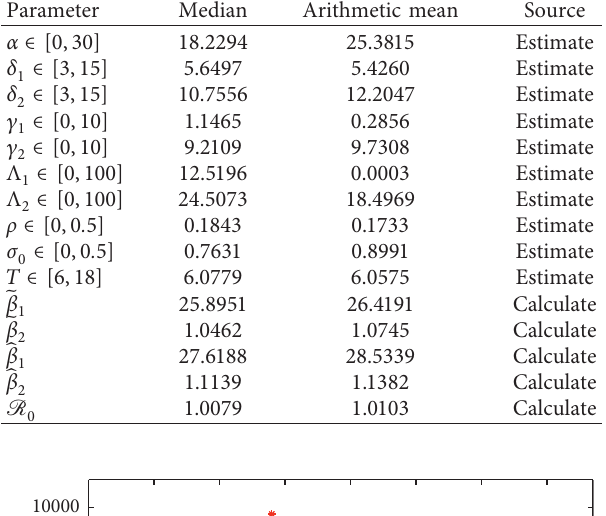
Table 3: The medians and arithmetic means of the parameters. Parameter Median Arithmetic mean Source